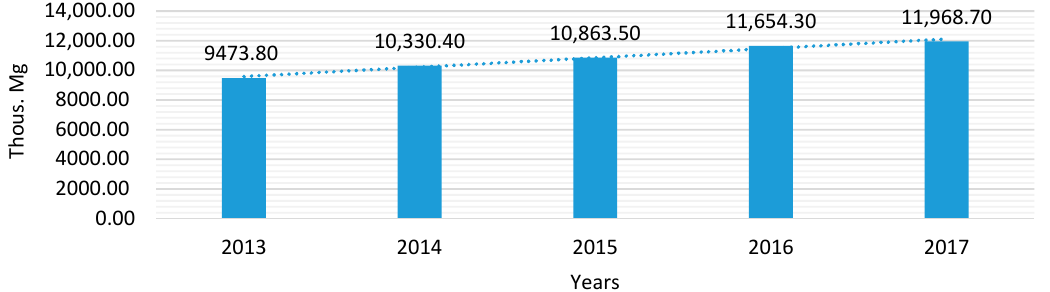
Figure 2. Amount of municipal solid waste in Poland [5–9].